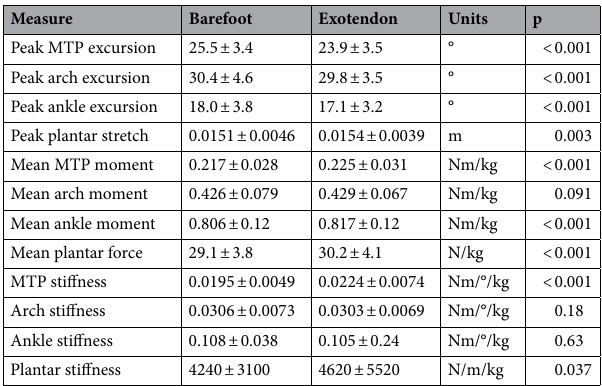
Table 1. Measures presented are averaged across all participants and are presented in the format mean ± standard deviation for the barefoot and exotendon conditions. The 5th column has the p-value for the fixed efficient coefficient for the exotendon condition in the linear mixed effects model, where p < 0.05 was considered